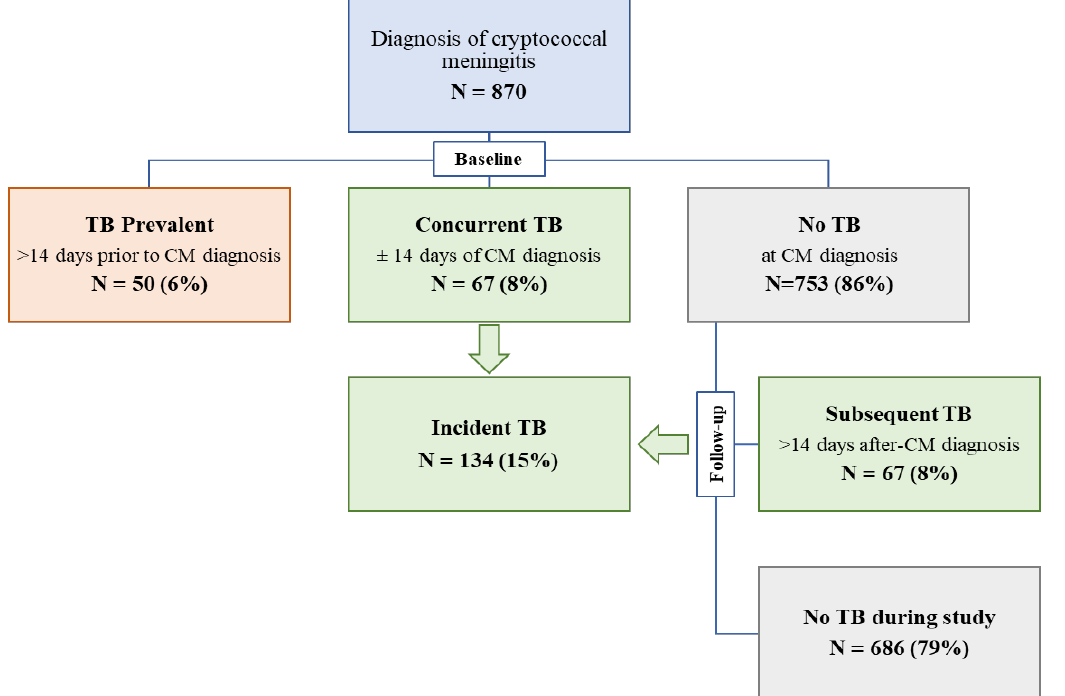
Figure 1. Classification of study participants. Patients with cryptococcal meningitis were classified at baseline ( ± 14 days of cryptococcal meningitis diagnosis) as ‘TB prevalent’, ‘concurrent TB’, or ‘no TB’. Those developing TB during study follow-up period were classified as ‘subsequent TB’. Incident TB included those with concurrent or subsequent TB. Abbreviations: CM, cryptococcal meningitis; TB, tuberculosis.